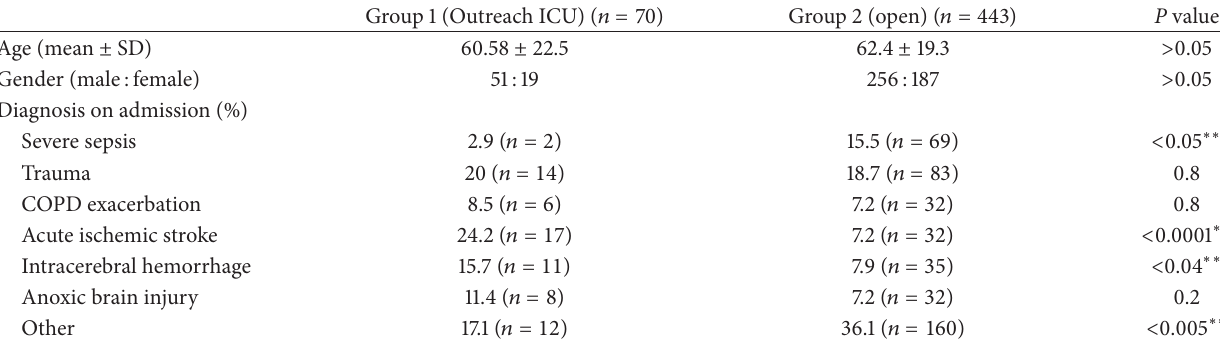
Table 2: Demographic data (mean ± SD,